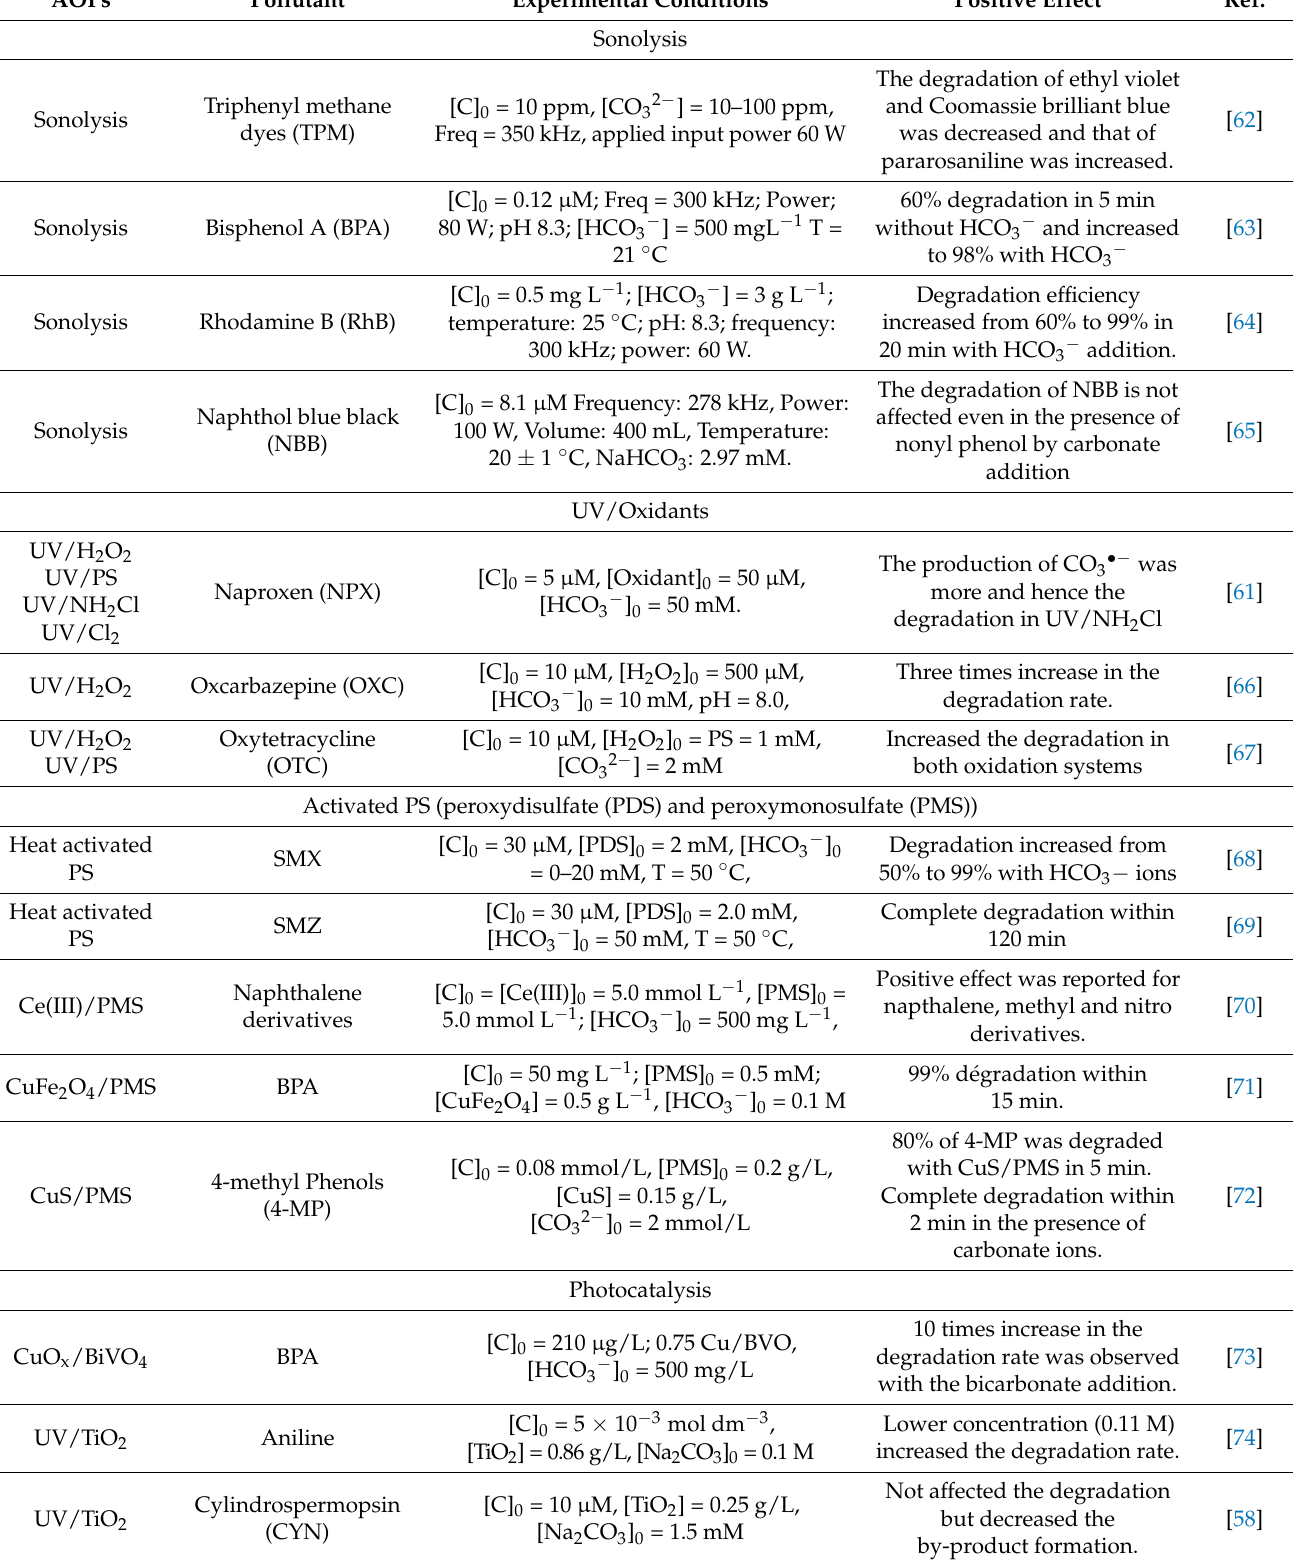
Table 1. The list of pollutants showing an improvement in the degradation in AOPs combined with carbonate